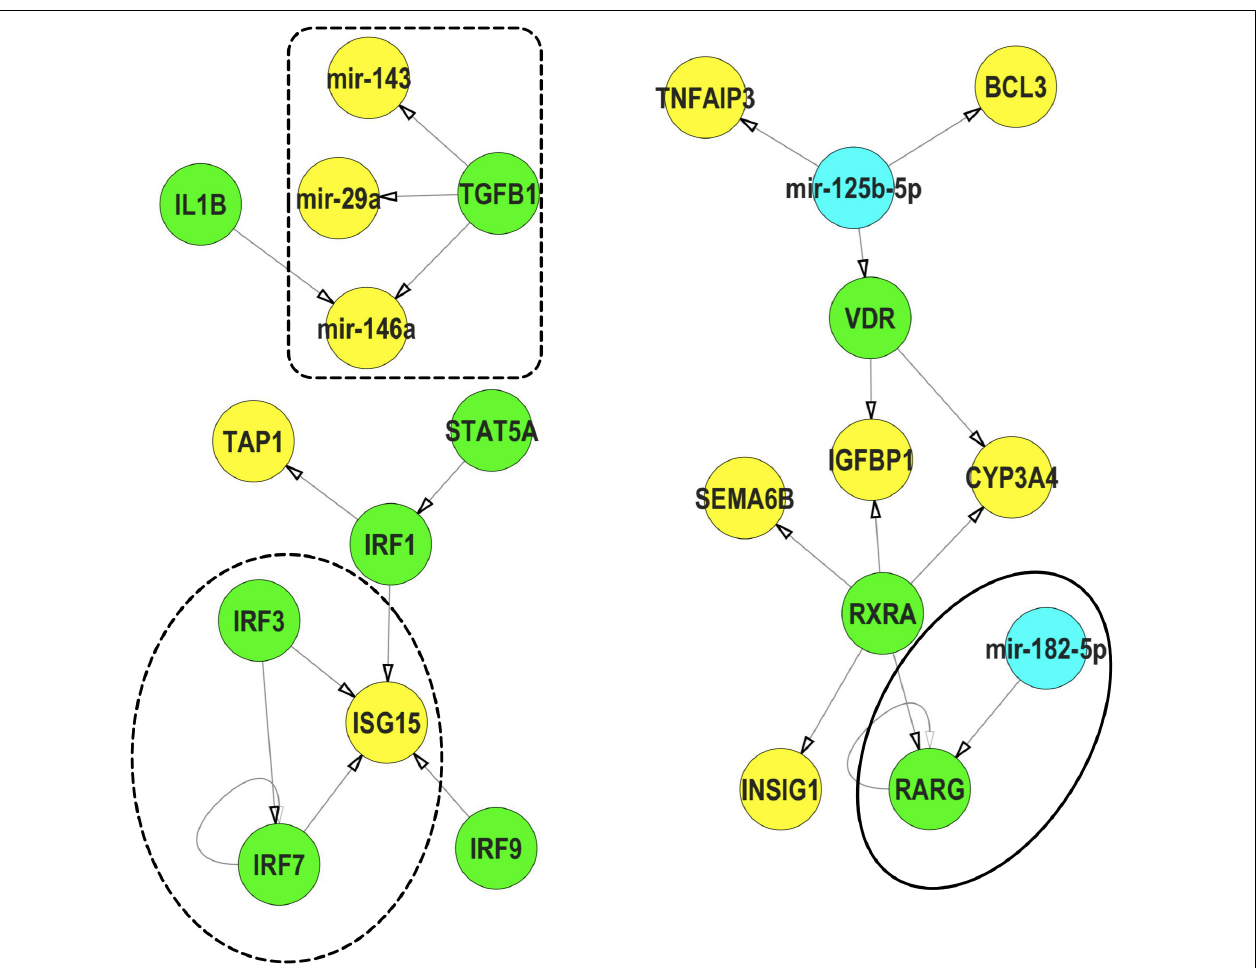
FIGURE 8 | Representative interactions between mRNA, miR and TFs that show a feed forward loop (FFL, dotted circle), a TF regulating a miR (dotted box) and a miR regulating a TF (solid circle) within IPP exposures. • TFs, • miRs, • mRNA. These interactions were selected from the mRNA-miR-TF co-regulatory network for IPP. All interaction data based on TFmiR experimentally validated